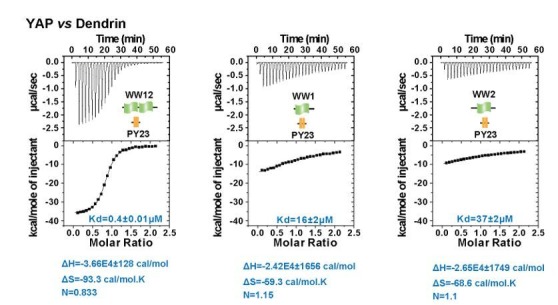
ITC experiments of YAP WW12 tandem and individual WW1 or WW2 titrated to Dendrin PY23.The fitted Kd and the corresponding calculated entropy change are indicated in the figure for each titration.